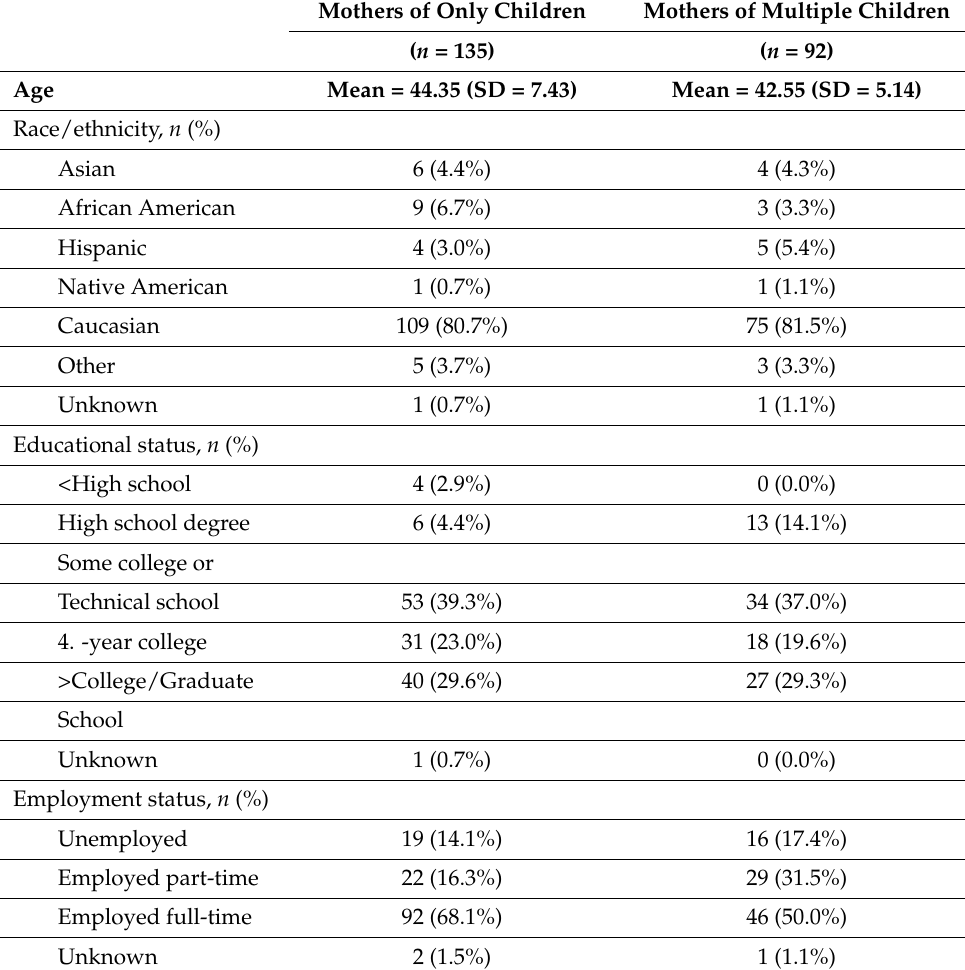
Table 2. Demographic and clinical characteristics of the mothers ( n =